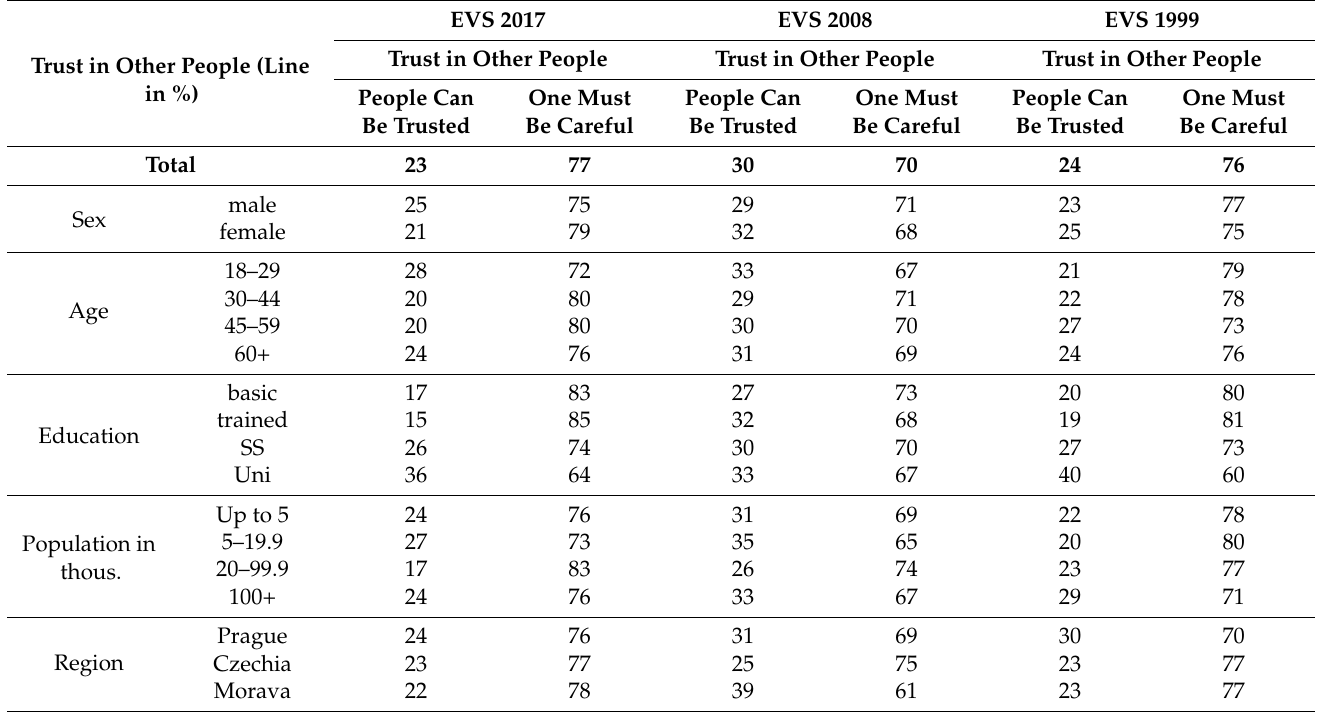
Table 1. Evolution of personal trust in Czechia from 1999–2017 in % in EVS measures